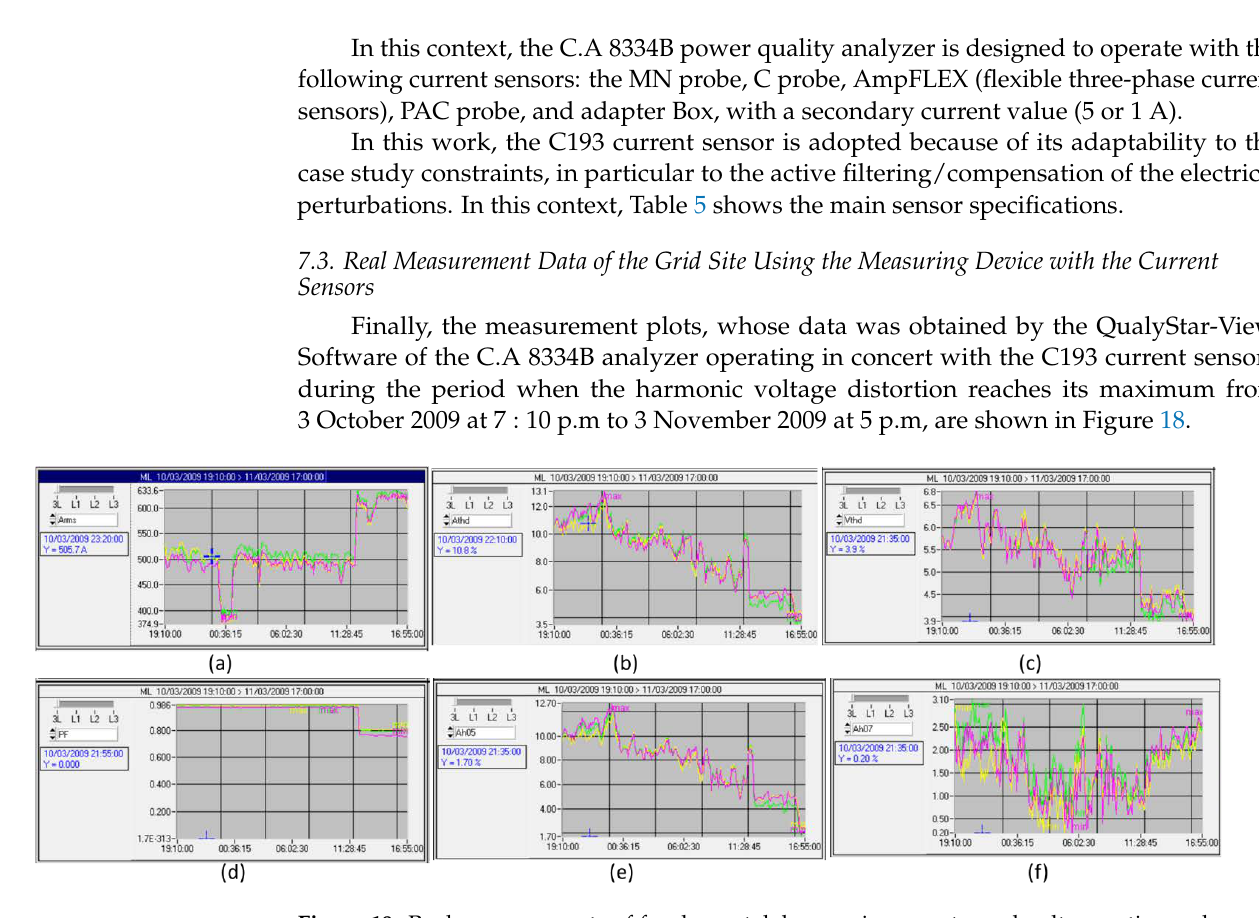
Figure 18. Real measurements of fundamental, harmonic currents, and voltage ratios and power factor using the power analyzer: ( a ) load current, ( b ) load current THD, ( c ) grid voltage THD, ( d ) power factor, ( e ) current harmonic distortion (rank 5), and ( f ) current harmonic distortion (rank